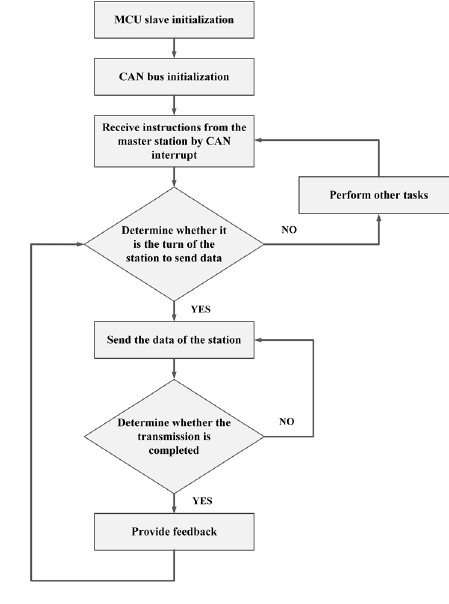
Figure 5a,b. Sensors 2019 , 19 , x FOR PEER REVIEW